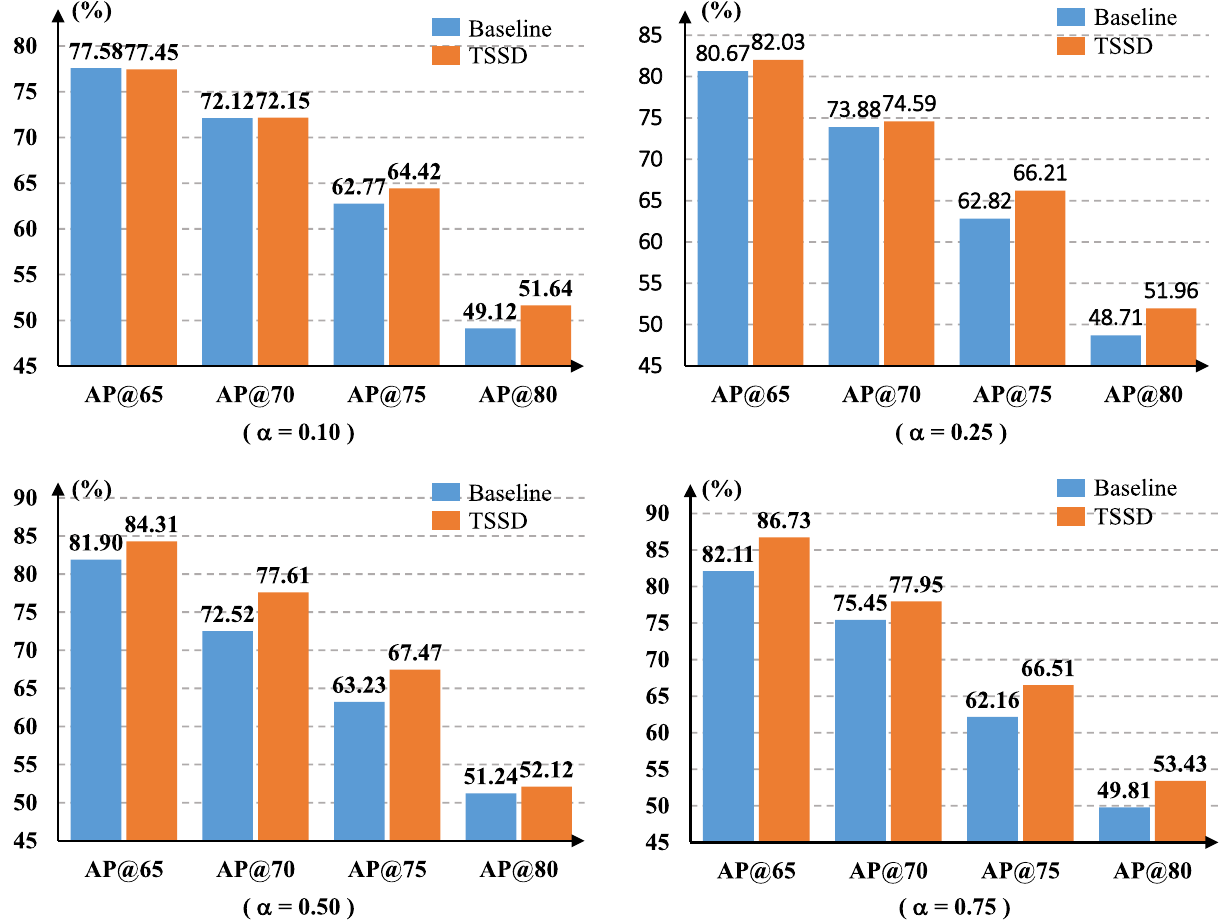
Figure 8. Comparison of accuracy between TSSD algorithm and the baseline model at different α